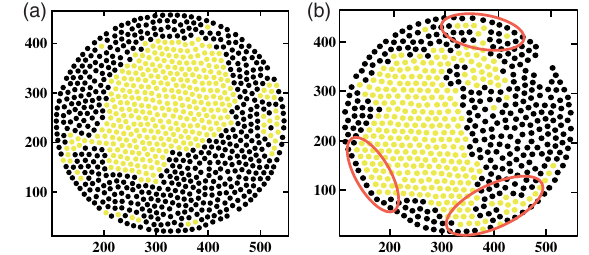
FIG. 10. Wall effects on the liquid-solid coexistence at Γ ¼ 3 . 3 . (a) A coexistence of the liquid and solid phase confined by a circular steel wall for ϕ ¼ 0 . 74 . The liquid phase preferentially wets the wall. (b) The same as (a) for a softer wall whose surface is covered by a silicone rubber film. In this case, the solid phase partially wets the wall (see the regions surrounded by the red lines).